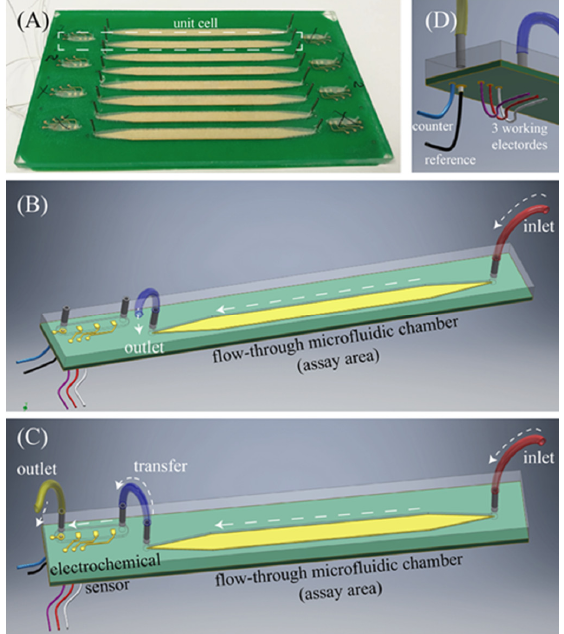
Figure 3. ( A ) Full PCB assay and electrochemistry board showing 8 independent assay areas (long gold strips) and 8 independent electrochemical cells (dashed line highlights a single unit